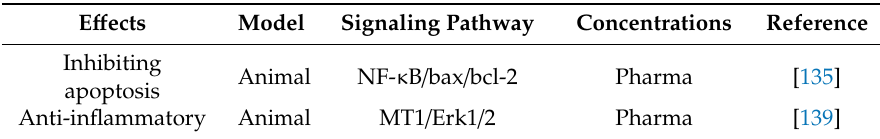
Table 4. Melatonin and multiple sclerosis.